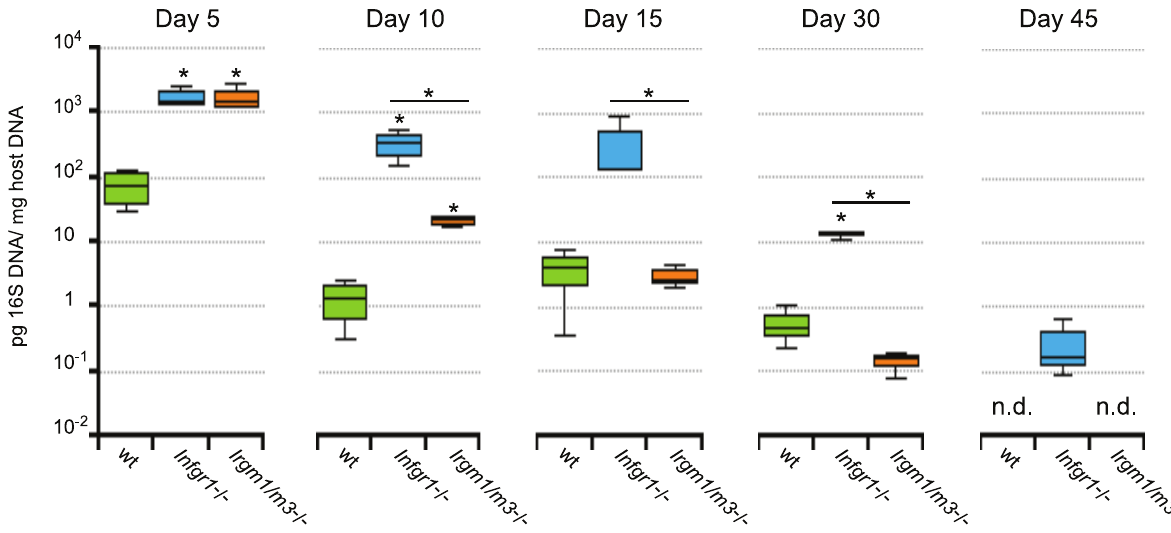
Figure 5. Irgm1/m3 (-/-) mice show delayed but efficient clearance of genital C.trachomatis infections. B6 wildtype mice and the coisogenic knockout strains B6. Ifngr1 -/- , and B6. Irgm1/m3 (-/-) were transcervically infected with 2 * 10 6 IFUs of C. trachomatis . At the indicated days post-infection 3 to 4 mice of each genotype were sacrificed and bacterial burden in the uteri was quantified by qPCR. Data were combined from two independent experiments. Statistical analysis of box-and-whisker plots was done via Student’s t test and significant difference relative to wildtype mice and between Ifngr1 -/- , and Irgm1/m3 (-/-) are indicated by *, p , 0.05. The limit of detection was approximately 10 2 4 pg 16S DNA/ m g host DNA.